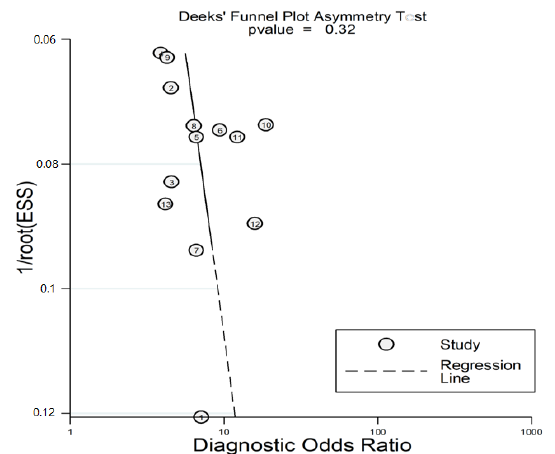
Figure 18. Deeks’ funnel plot asymmetry test for assessment of publication bias.